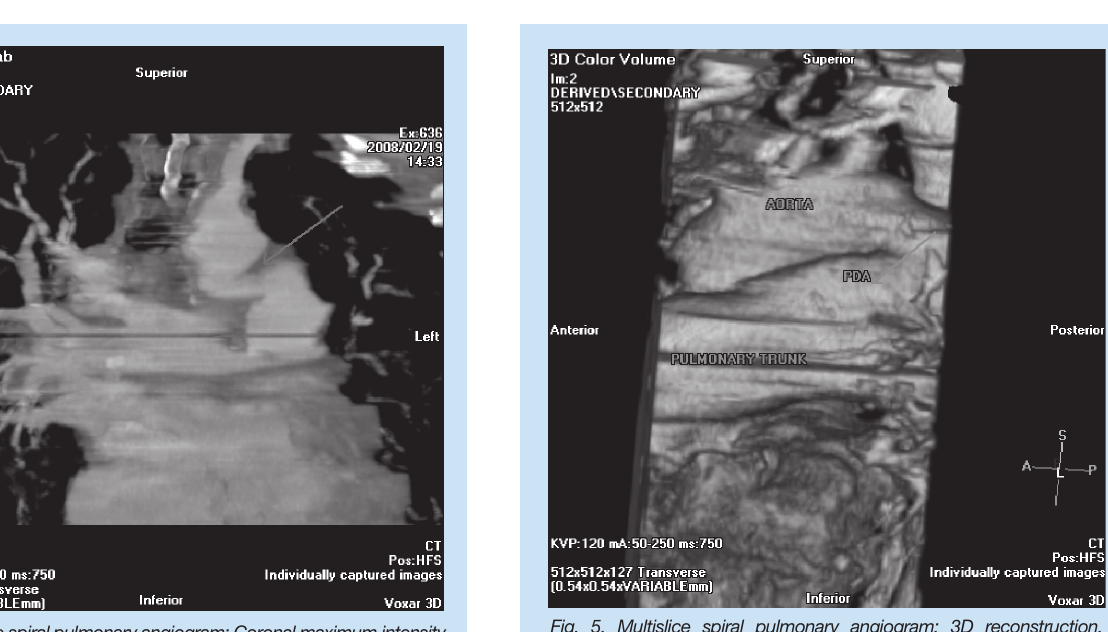
Fig. 3. Multislice spiral pulmonary angiogram: Coronal maximum intensity projection; arrow points to PDA.